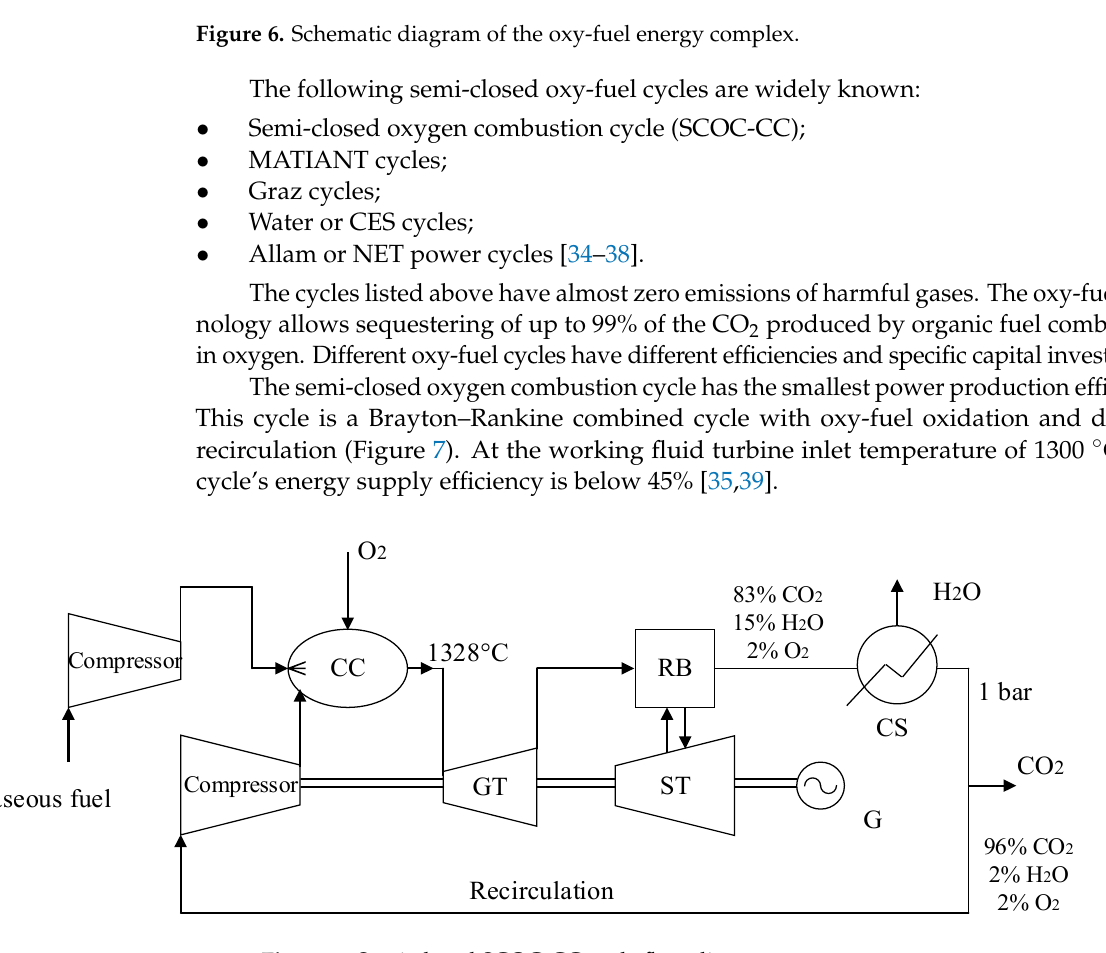
Figure 7. Semi-closed SCOC-CC cycle flow diagram.